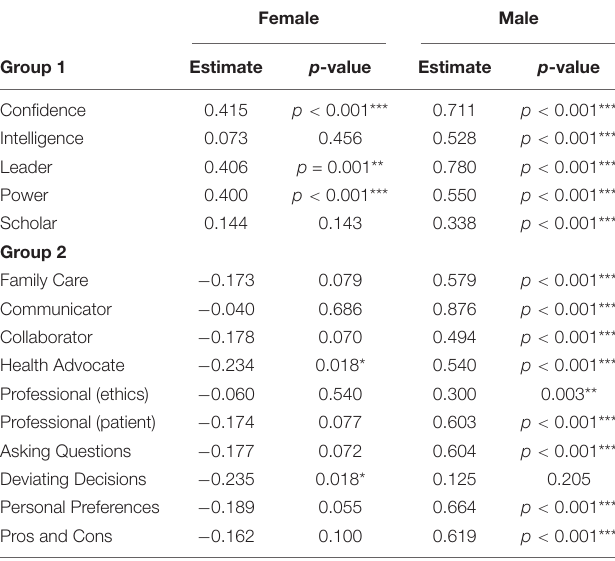
Figure 2 ) is found with respect to the CanMEDS role